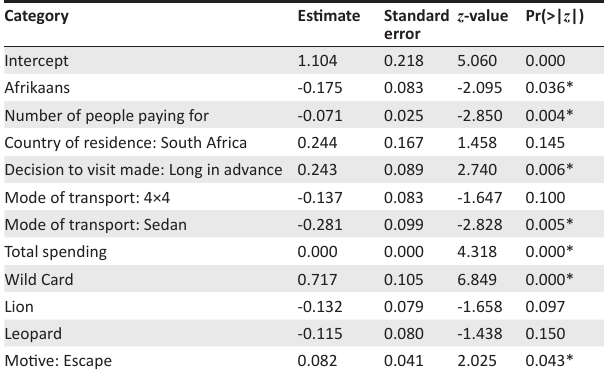
TABLE 5: Results of the negative binomial regression analysis.